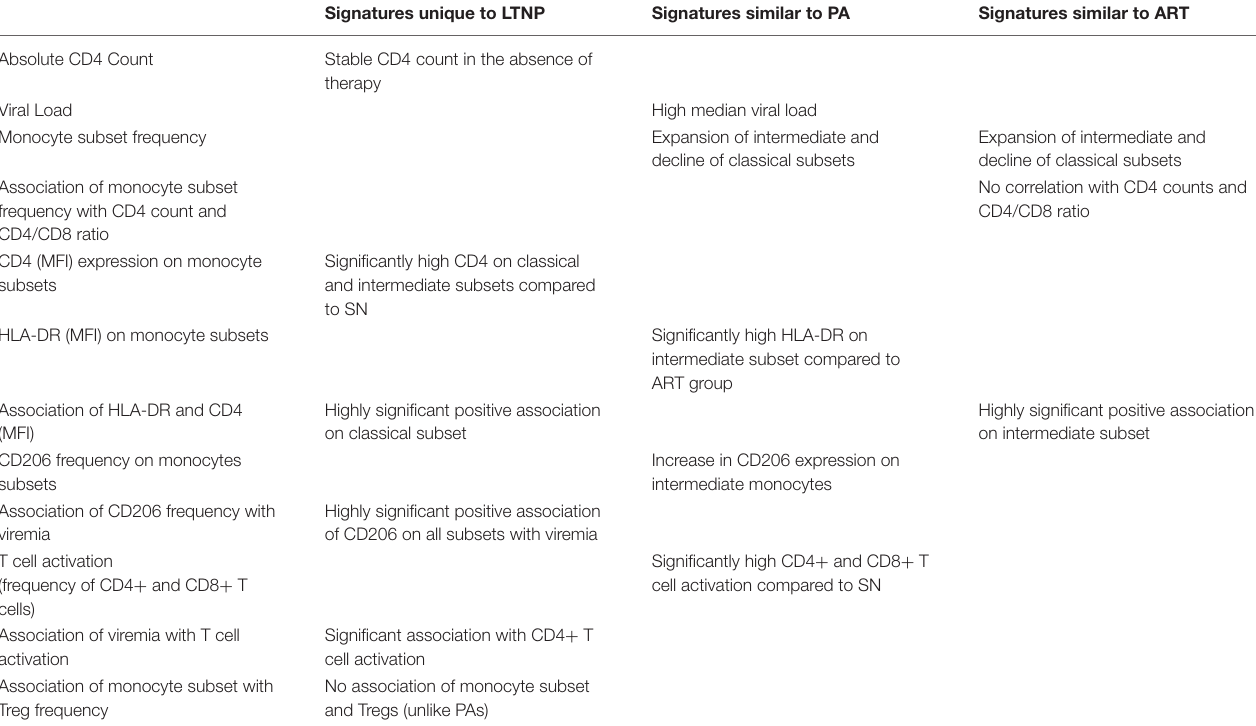
TABLE 4 | Immune signatures of non-progression. Signatures unique to LTNP Signatures similar to